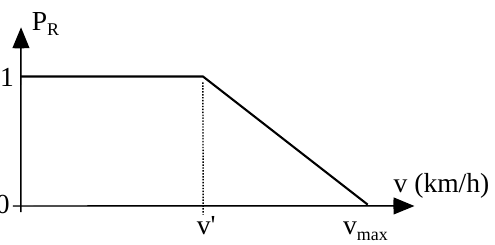
Figure 30. Assisted power ratio P R as a function of the velocity v